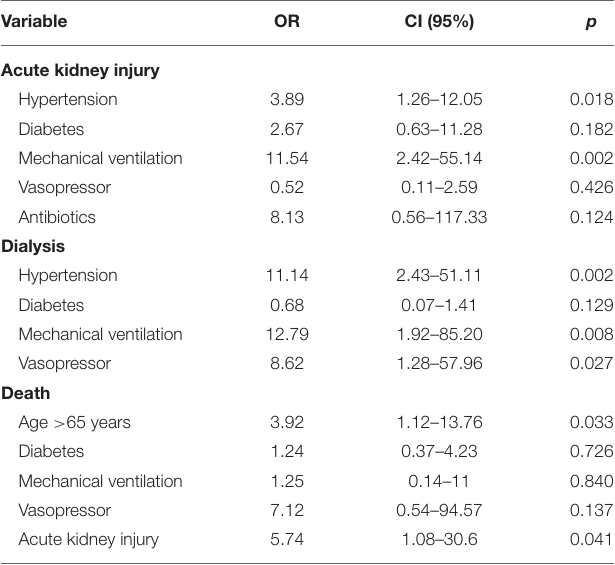
TABLE 3 | Multinomial logistic regression predicting the risk factors for AKI, dialysis and death.